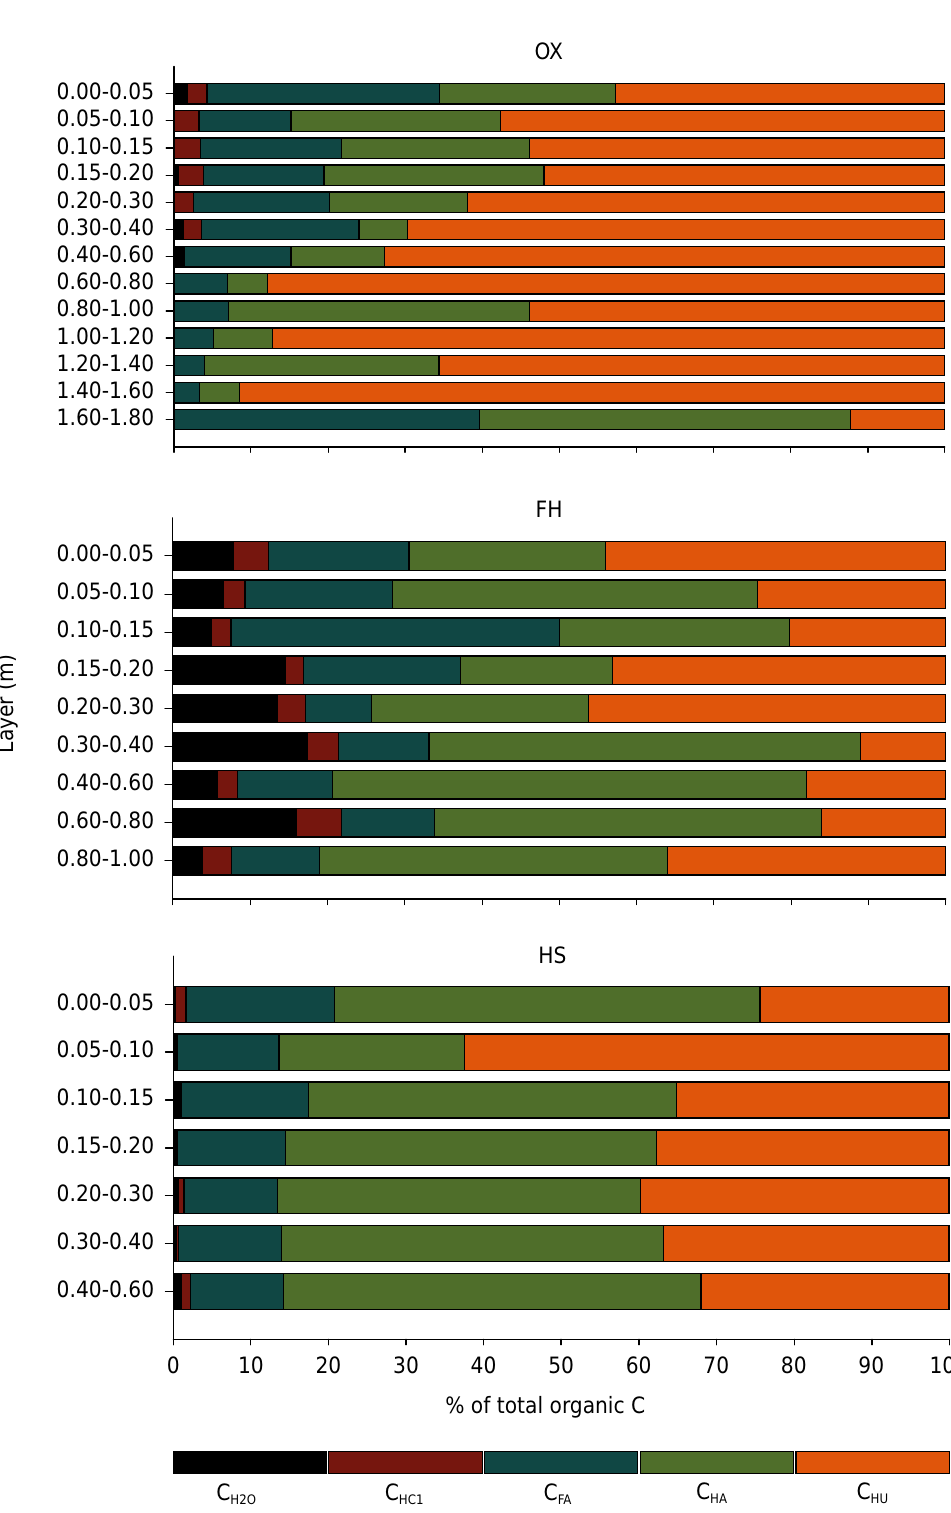
Figure 2. Proportion of soil organic matter fractions in total organic carbon of a Humic Hapludox (OX), a Fluvaquentic Humaquepts (FH), and a Typic Haplosaprists